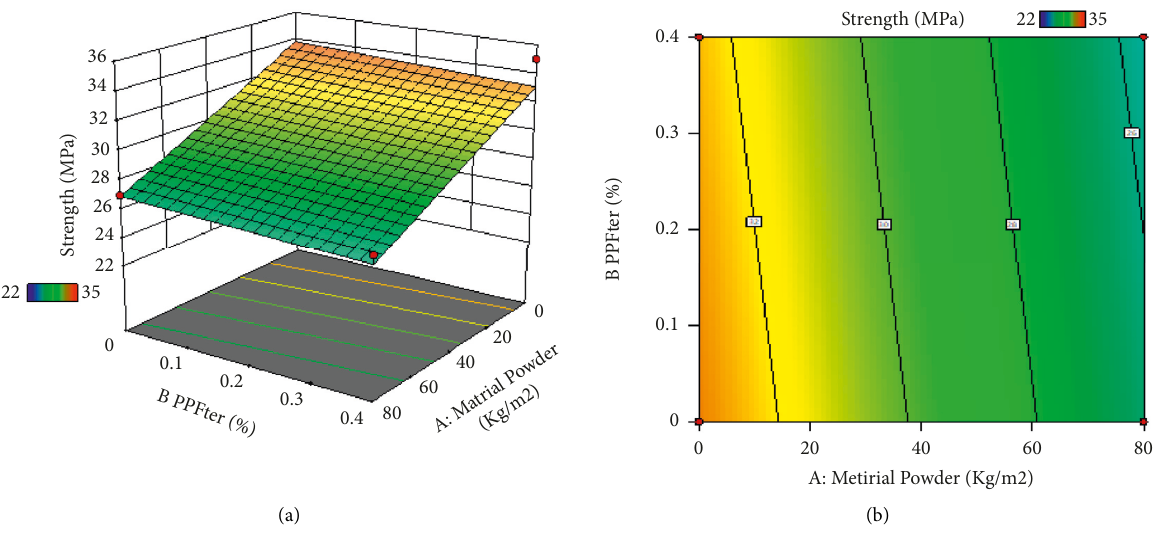
Figure 5: 2D contour plot for split tensile